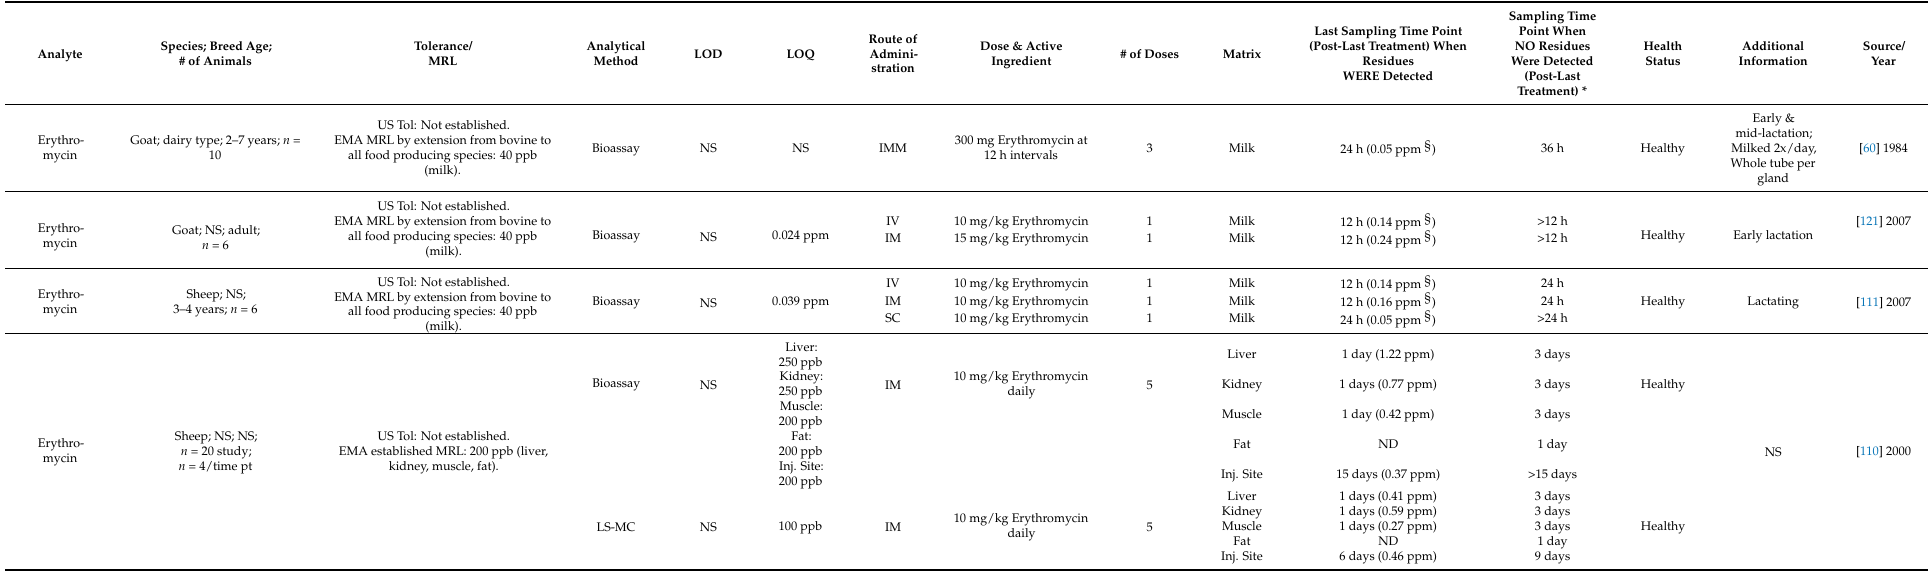
Table 6. Macrolide residues in milk or edible tissue samples from sheep or goats following